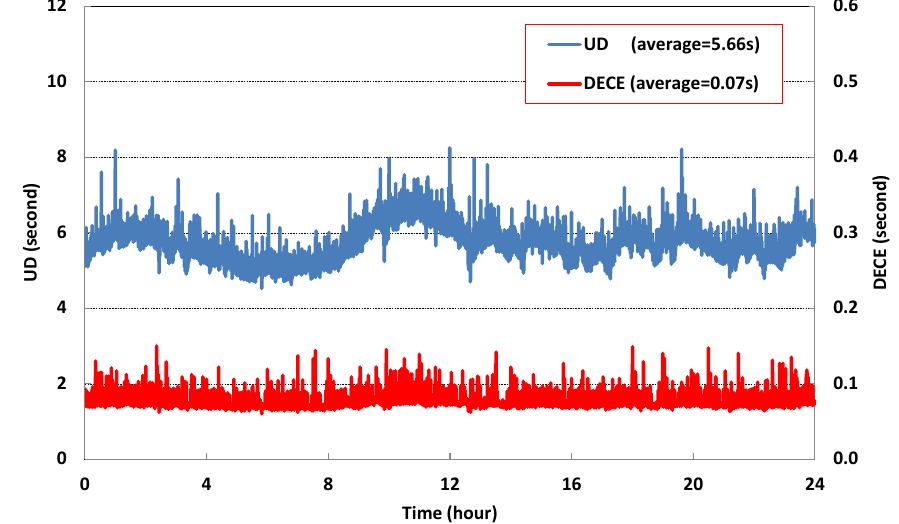
Figure 6. Computational time at each epoch using undifferenced (UD) and decentralized clock estimation (DECE) modes for Day of Year (DOY) 251, 2018.